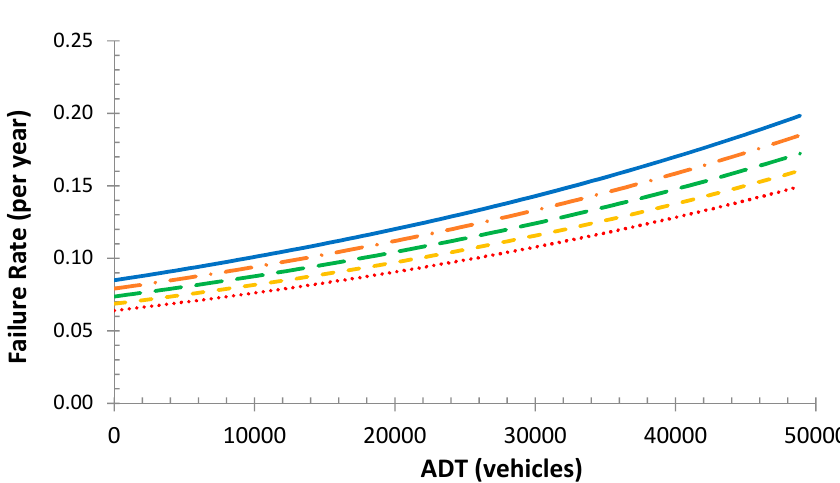
Figure 6. Superstructure reliability and hazard rate versus ADT at different MSL values at the age of 75 years (All superstructure types).